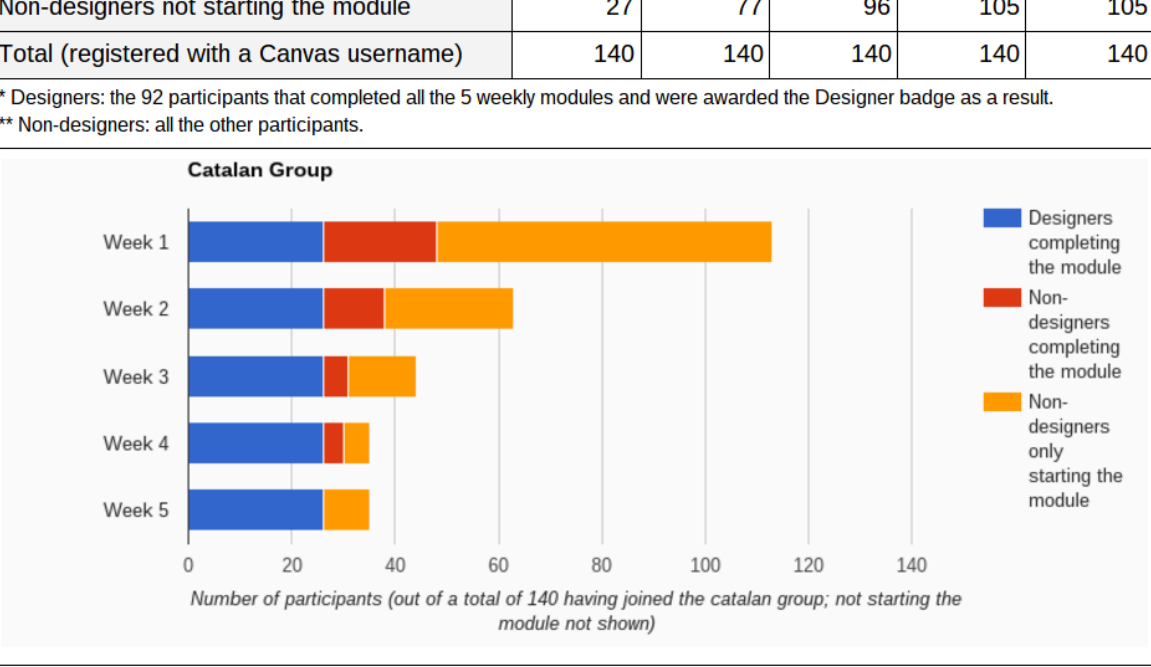
Figure 4. Catalan group: Participation in weekly modules of